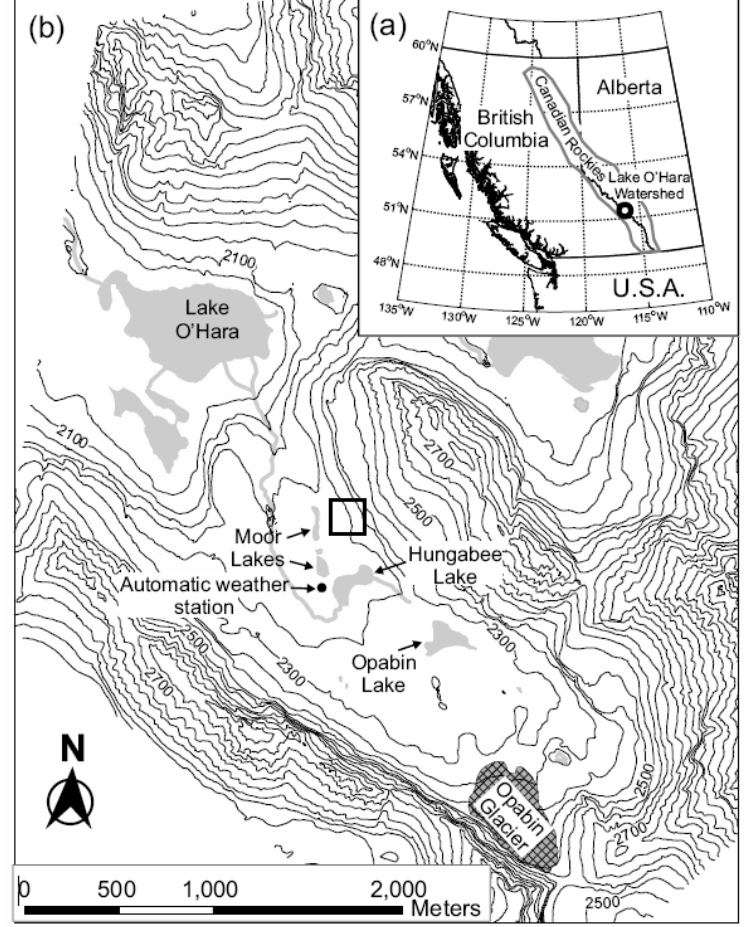
Fig. 1. Topographic map of the Opabin watershed showing Opabin Creek (gray solid line), major lakes (gray bodies), a glacier (stippled), and the automatic weather station (AWS). Black square indicates the location of the hydrological and geophysical surveys on the talus-meadow complex shown in Figs. 2 and 3. Contour interval is 50m. The insert shows the site location in North